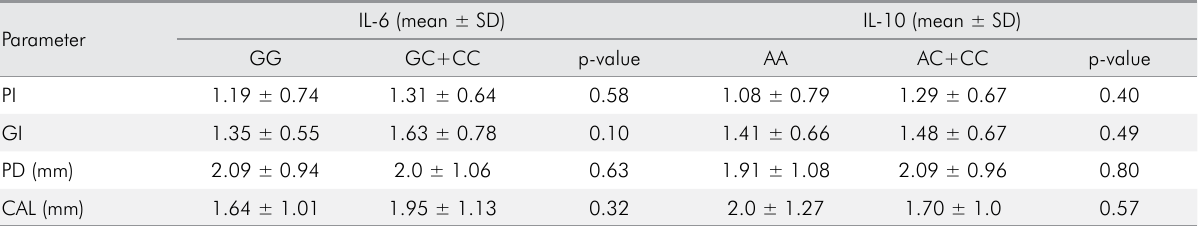
Table 7. Differences of clinical parameters in generalized aggressive periodontitis patients (at baseline and 6-week) distributed by IL-6 and IL-10